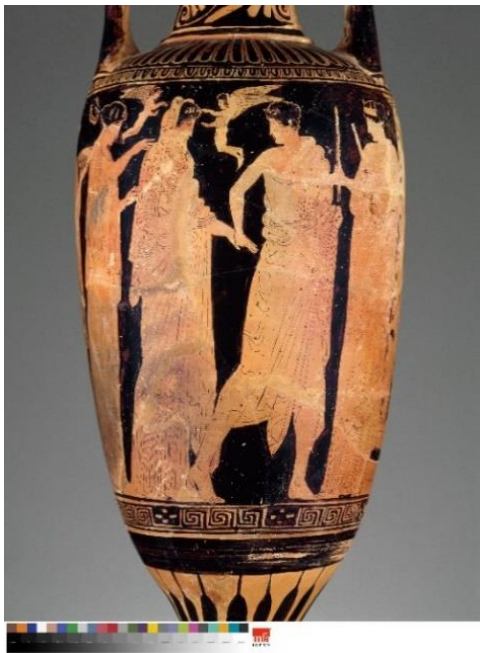
Figure 10. Athenian red-figure loutrophoros showing wedding procession, attributed to Polygnotos. 430 – 420 BCE. Vase said to be found near Athens. Toronto, Royal Ontario Museum of Art 929.22.3, BAPD 213434. Credit: With permission of the Royal Ontario Museum © ROM. Arts 2019 , 8 , x FOR PEER REVIEW